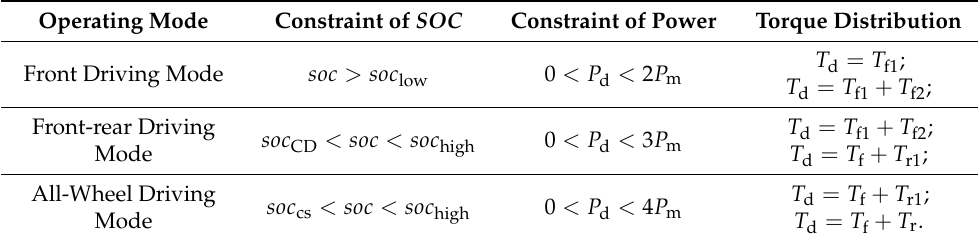
Table 2. The operation model of rule-based energy management